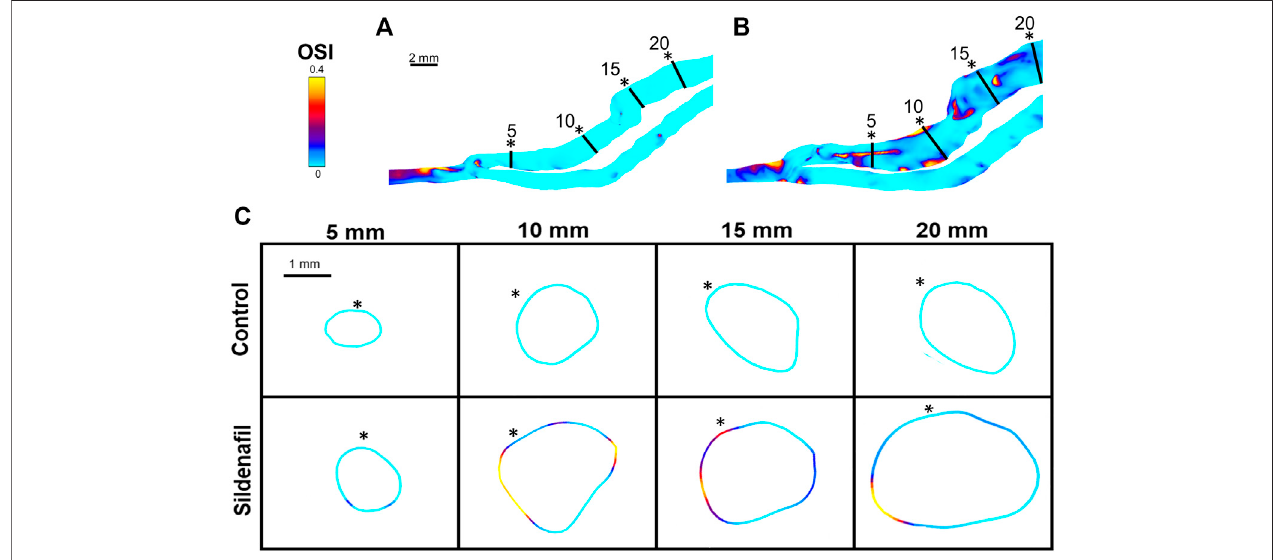
FIGURE 7 | OSI color maps. (A,B) OSI for AVFs in a control rat (A) and a sildena fi l treated rat (B) . (C) Color maps of OSI for control (top) and sildena fi l (bottom) treated rats at 5, 10, 15, and 20 mm away from the anastomosis. Black lines in panels Aand B represent the slice locations in panel C. * in panel C represents the top of the slice as shown in panels A and B. Color bar applies to (A – C) . Scale bar in A applies to A-B.